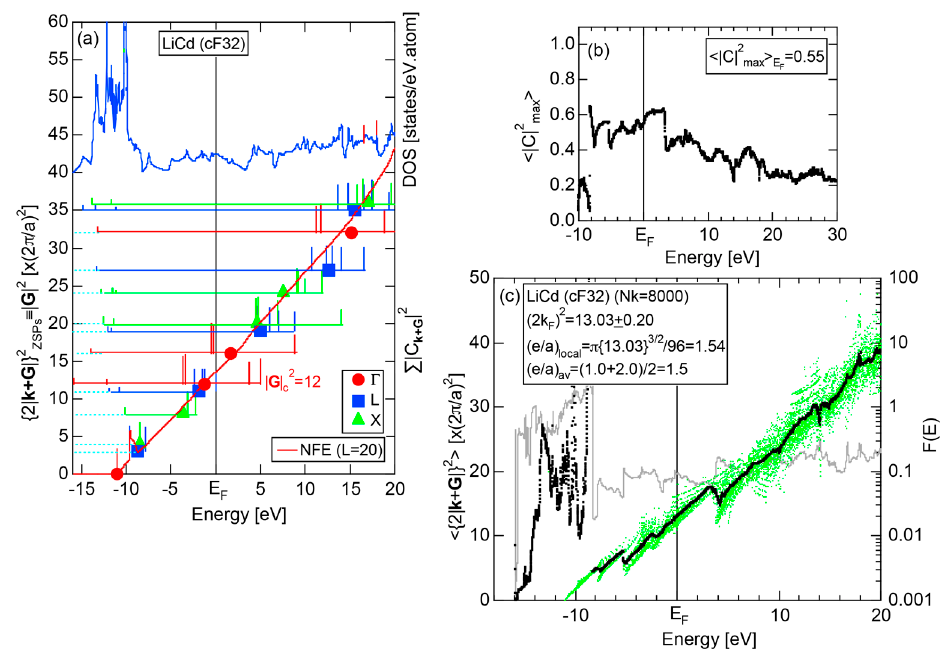
Figure 65. ( a ) FLAPW-Fourier spectra at symmetry points Γ , L, X of the fcc Brillouin zone along with the total DOS; ( b ) C and ( c ) Hume-Rothery plot for LiCd (cF32) [11,41]. See captions of Figure 19 (b) for symbols in ( c ).